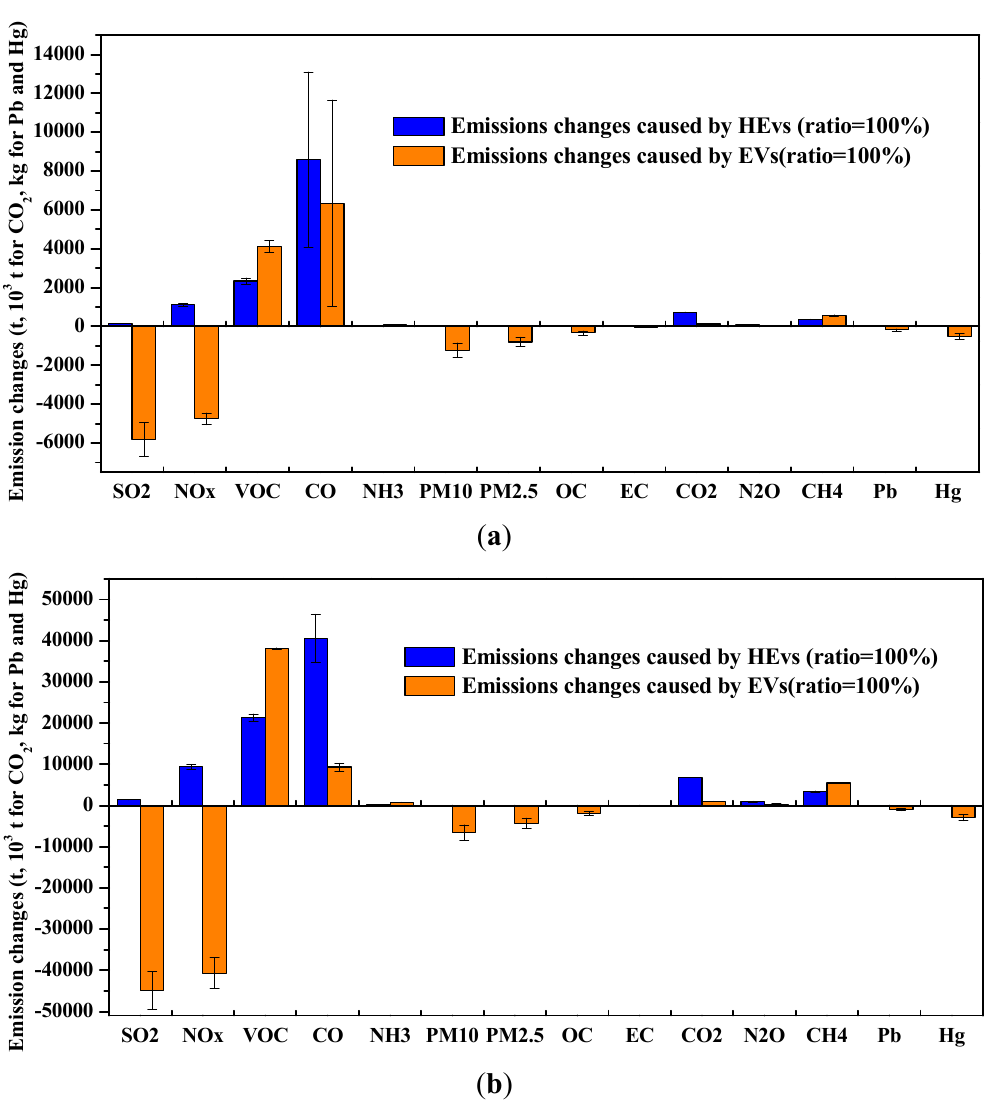
Figure 5. The pollutants emission changes caused by HEVs and EVs in China (positive represents reduction, negative represents increase): ( a ) 2015 and ( b )